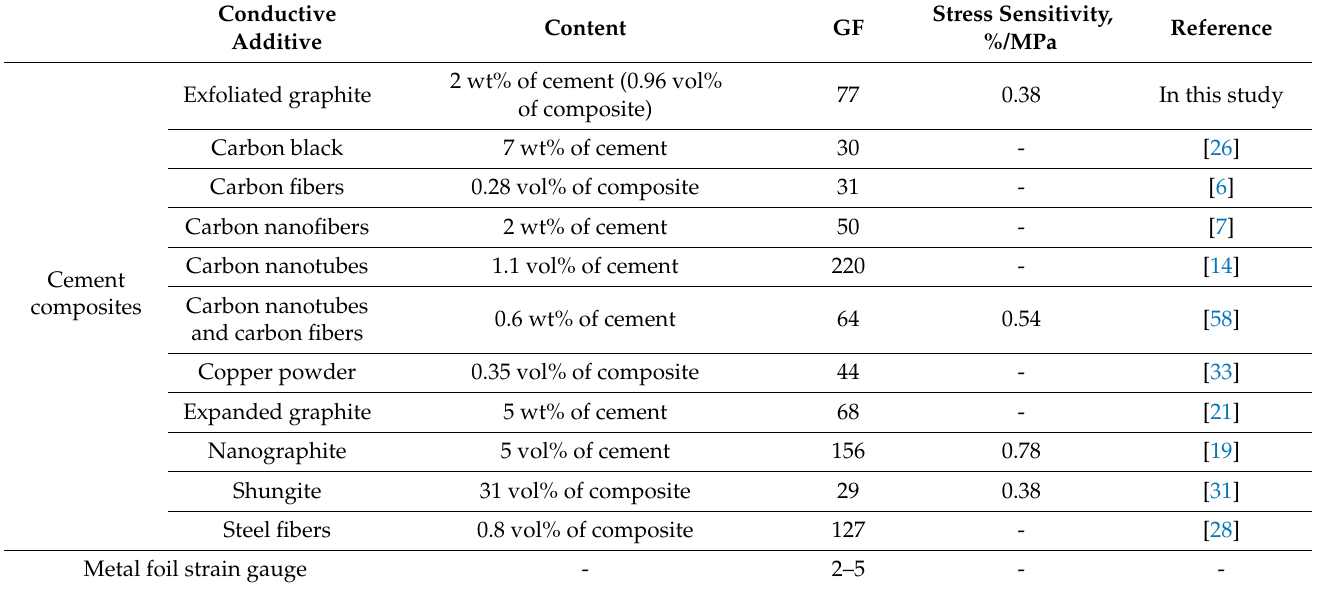
Table 3. Comparison of sensitivity of cement composites with conductive additives.